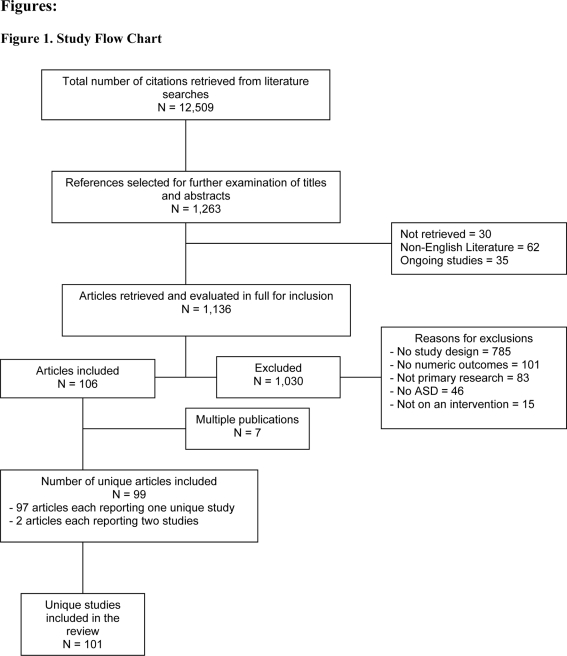
Study Flow Chart.